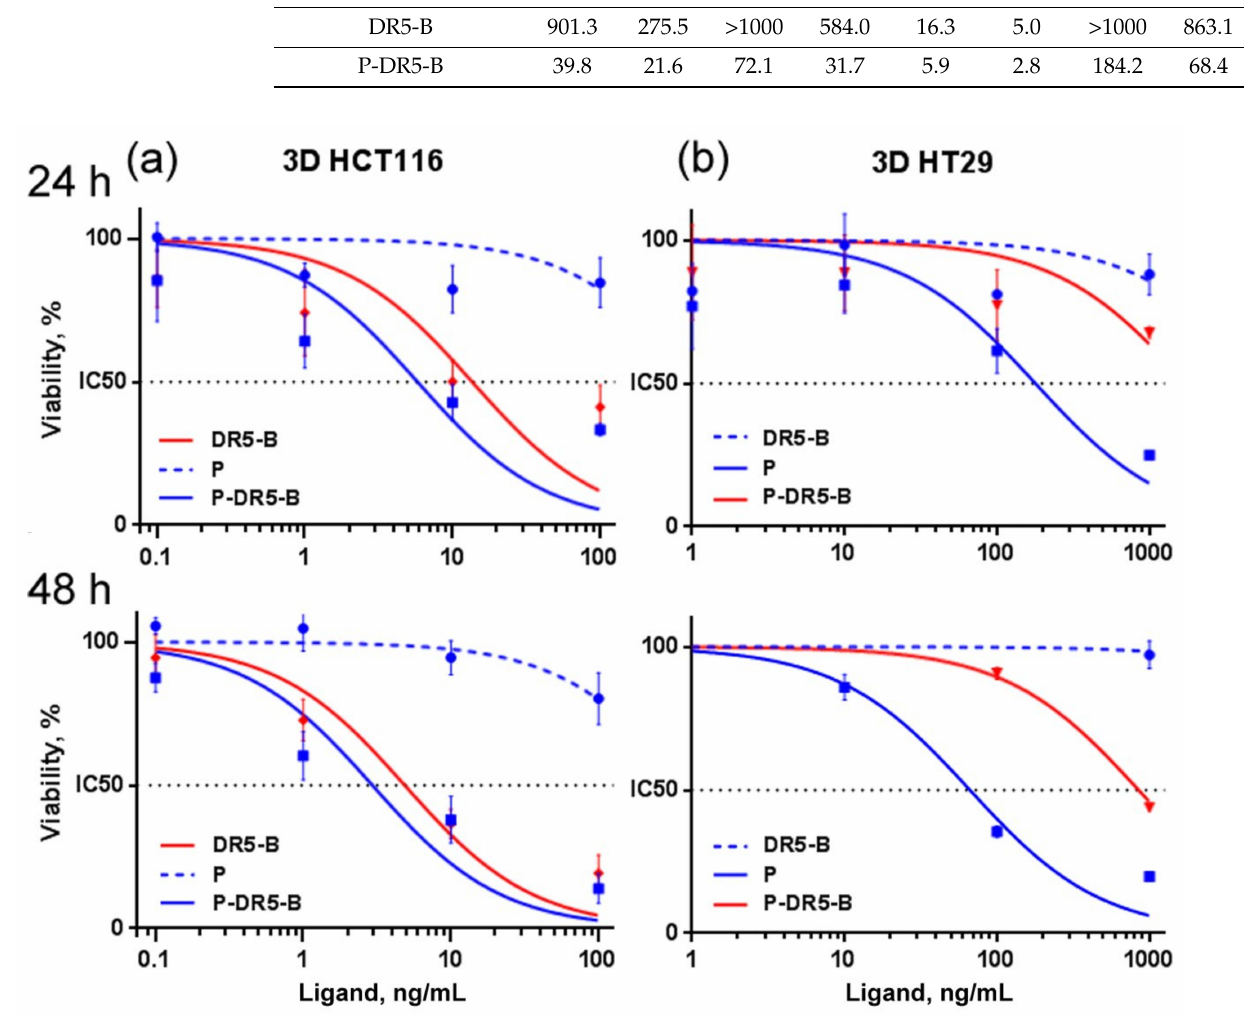
Figure 4. Cytotoxicity of the P-DR5-B nanoparticles in 3D human tumor models of ( a ) colorectal carcinoma HCT116; ( b ) colorectal adenocarcinoma HT29 in vitro for 24 and 48 h. Cell viability was determined by the MTT test. Mean ± Standard Deviation ( n =